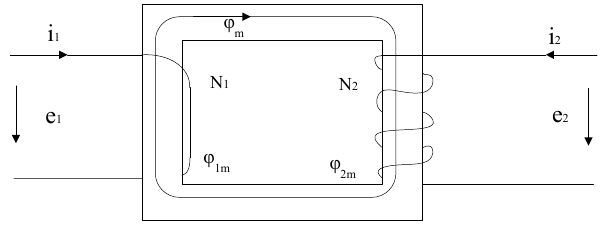
Figure 1. CT coupling relationship power extraction diagram.